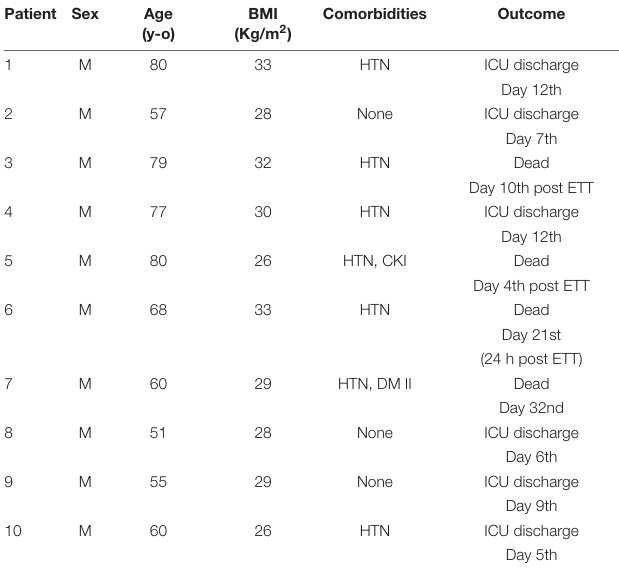
TABLE 1 | Demographics data and outcome.